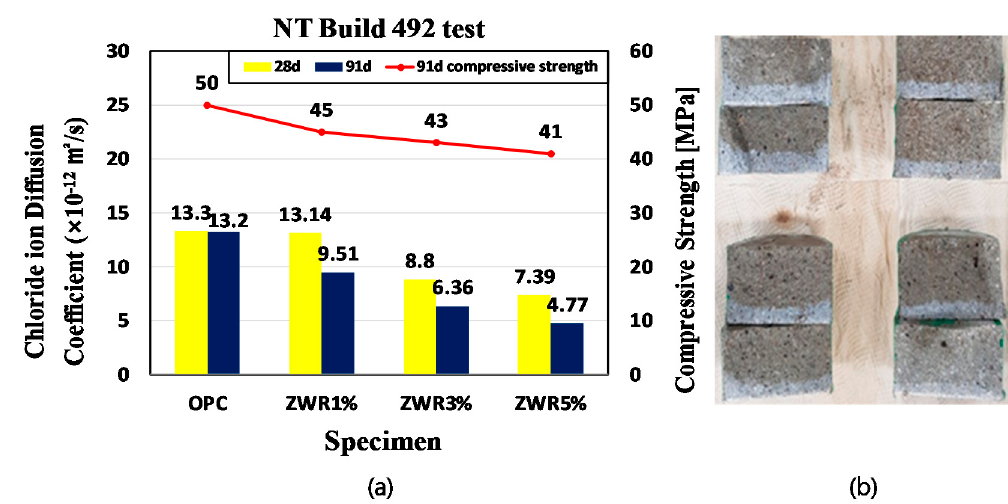
Figure 13. ( a ) Graph of evaluation of resistance to chloride ion penetration test; ( b ) Cross-section of the test specimen after chloride penetration.